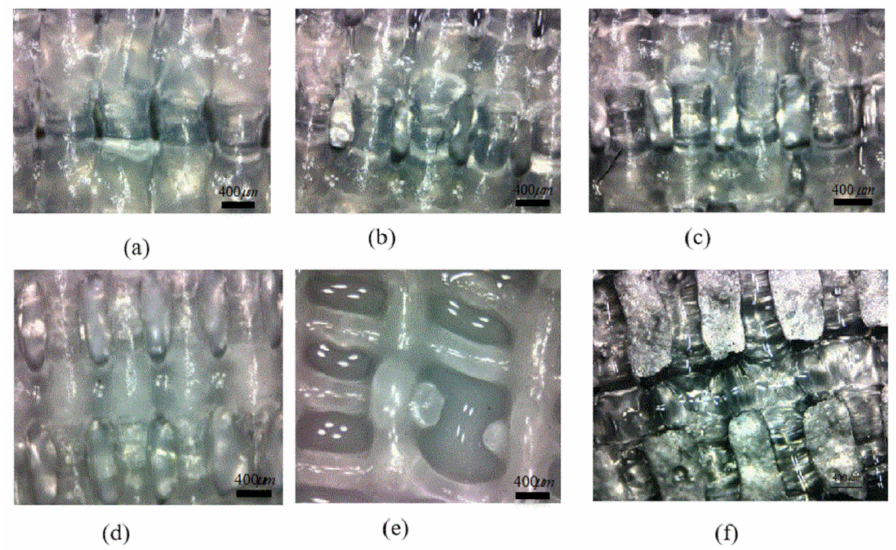
Figure 10. Micro-view of midline of sca ff old at di ff erent moving speeds. ( a ) extrusion line with moving speed 4 mm / s; ( b ) extrusion line with moving speed 7 mm / s; ( c ) extrusion line with moving speed 10mm / s; ( d ) extrusion line with moving speed 13 mm / s; ( e ) extrusion line with moving speed 16 mm / s; ( f ) extrusion line with moving speed 20 mm / s.